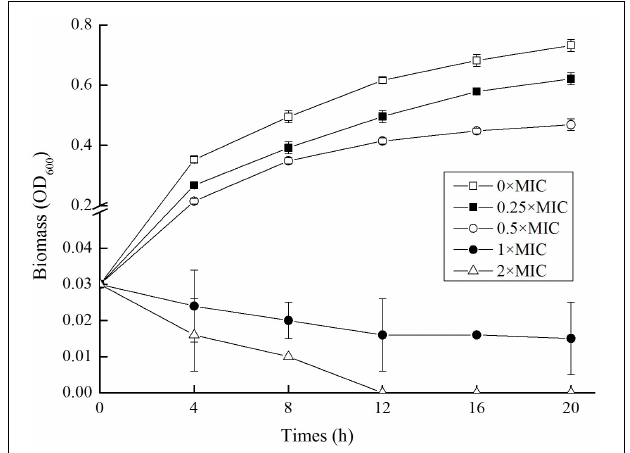
FIGURE 1 | Growth curves of Salmonella cells exposed to different doses of chlorogenic acid (CGA).